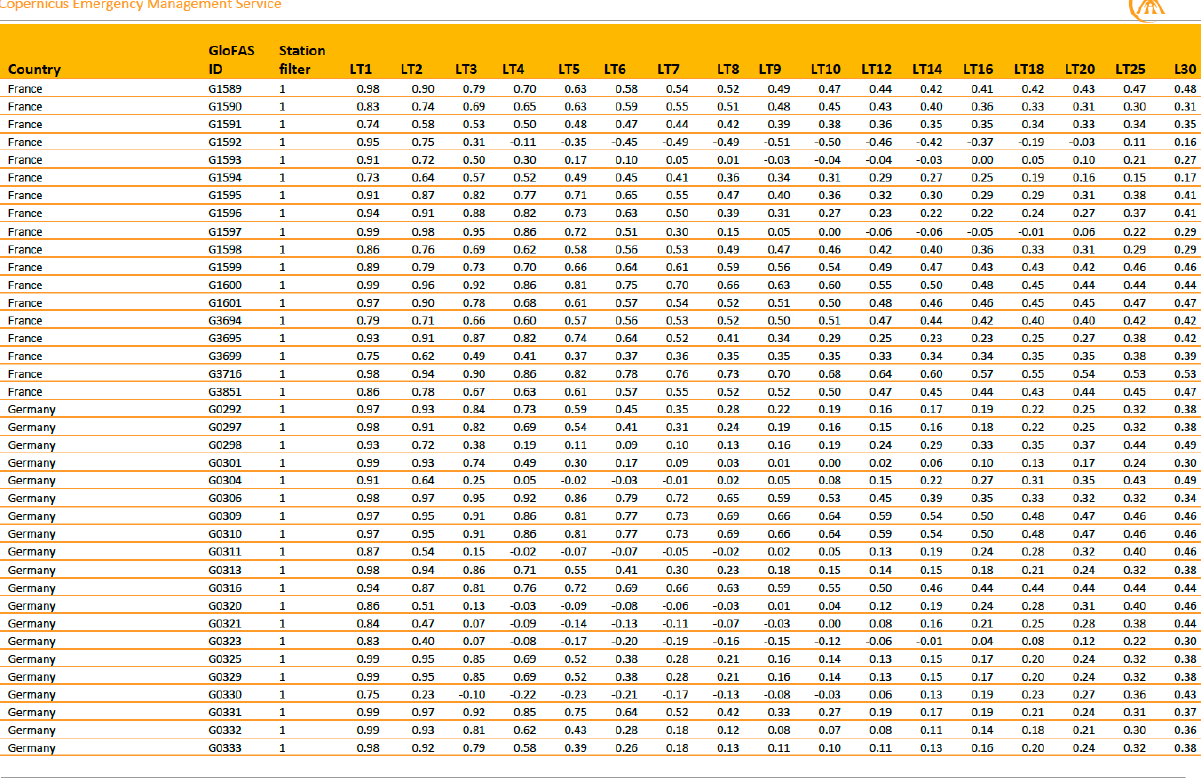
Figure 11. Extract of GloFAS 2.1/2.2 river discharge forecast skill scores for CRPSS against persistence provided for a selection of lead times (LT) out to 30d ahead as metadata information available through the Climate Data Store (CDS) documentation tab for each of the GloFAS diagnostic points as well as in Table